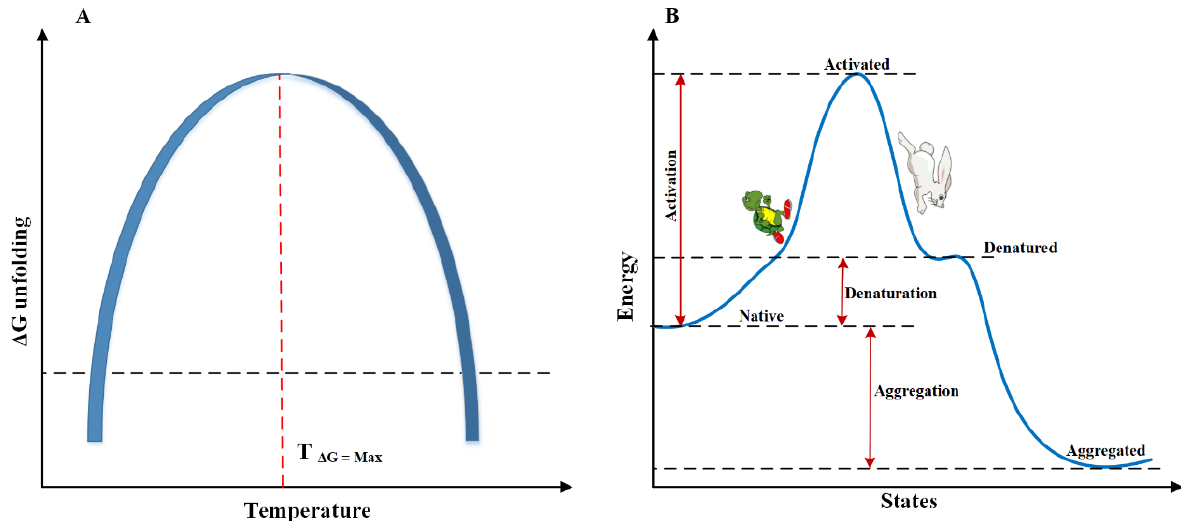
Figure 2. The relationship between protein unfolding and internal energy (the data were extracted from [21,38]). ( A ) Shows the possible quantities of Δ G unfolding at different temperatures. ( B ) Indicates the several stages of the protein unfolding pathway. At first, by obtaining energy, the protein is activated to higher levels by increasing the amount of internal energy, and at a critical point, it unfolds by releasing energy to reach a more stable state. In a large number of studies, it is believed that the most stable state of a protein is its aggregated form (fibril form), however, some researchers believe that its natural form is the most stable state.